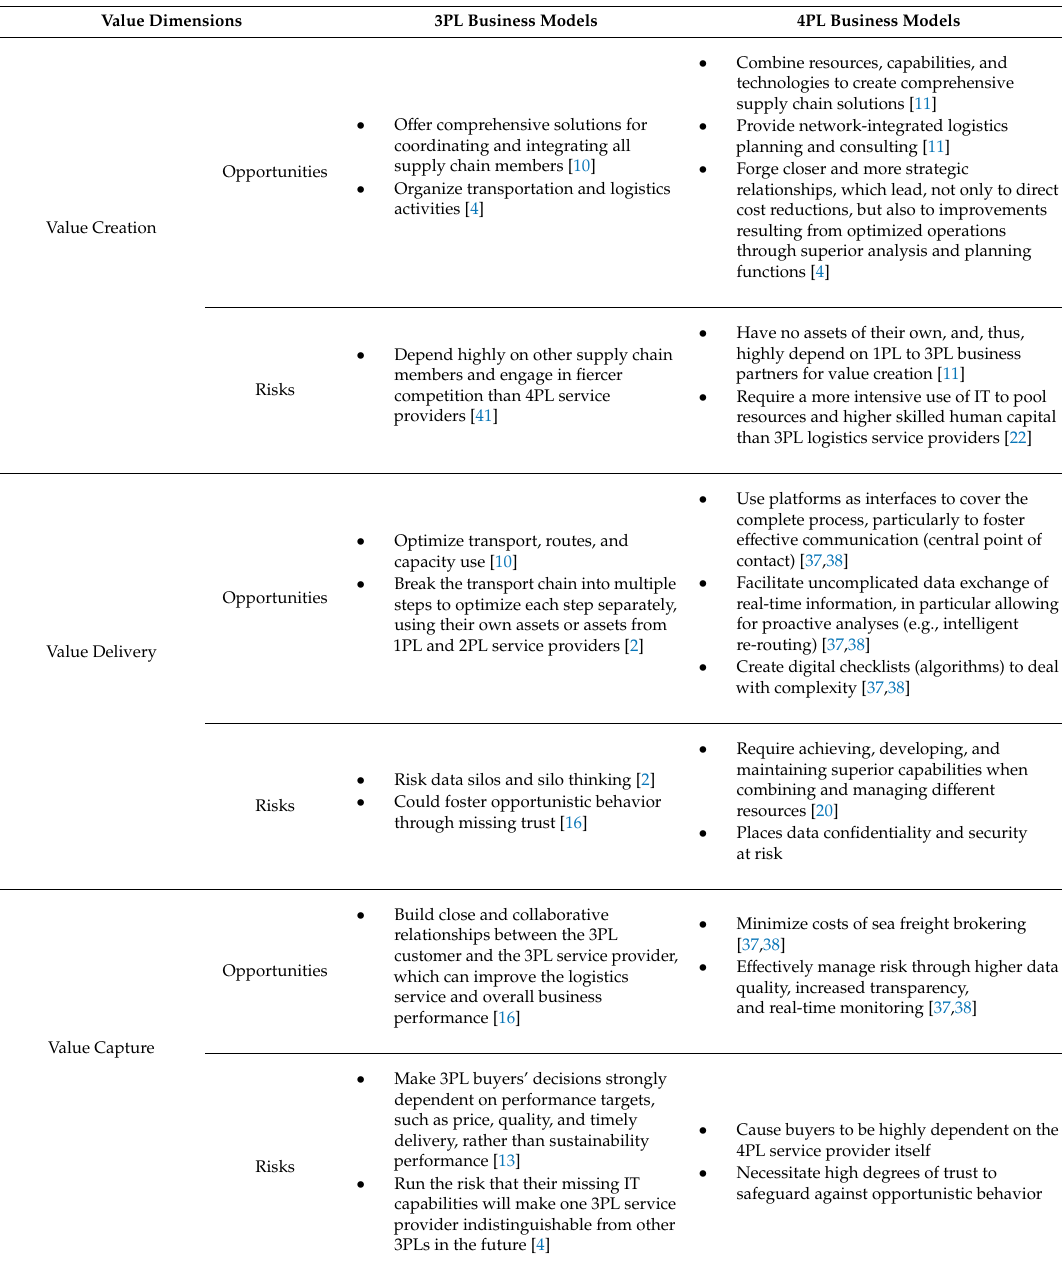
Table 6. Comparison of 3PL and 4PL business